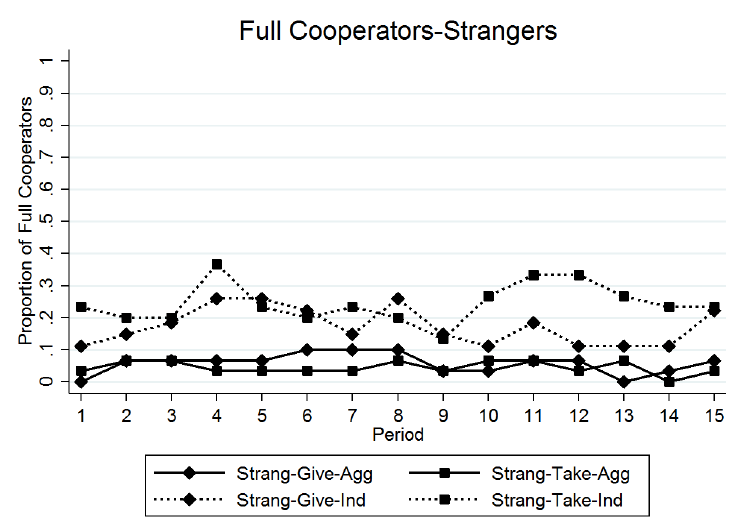
Figure 6. Proportion of Full Cooperators Over Time